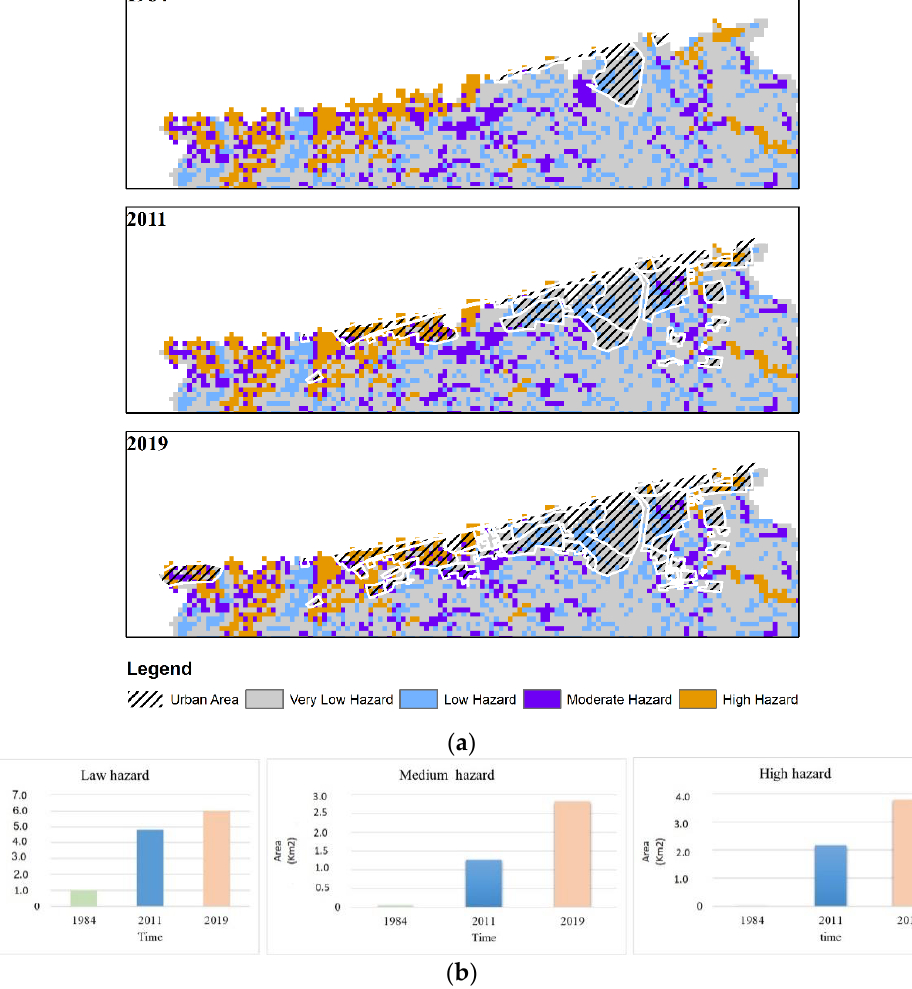
Figure 17. Inundation maps showing the hazard levels affecting the urban areas ( a ) and estimates of the vulnerable areas for flood hazard categories ( b ) over time from 1984 to 2019 in Al-Arish.